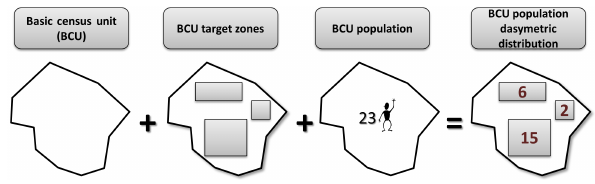
Figure 3. Schematic dasymetric evaluation of population based on target zone